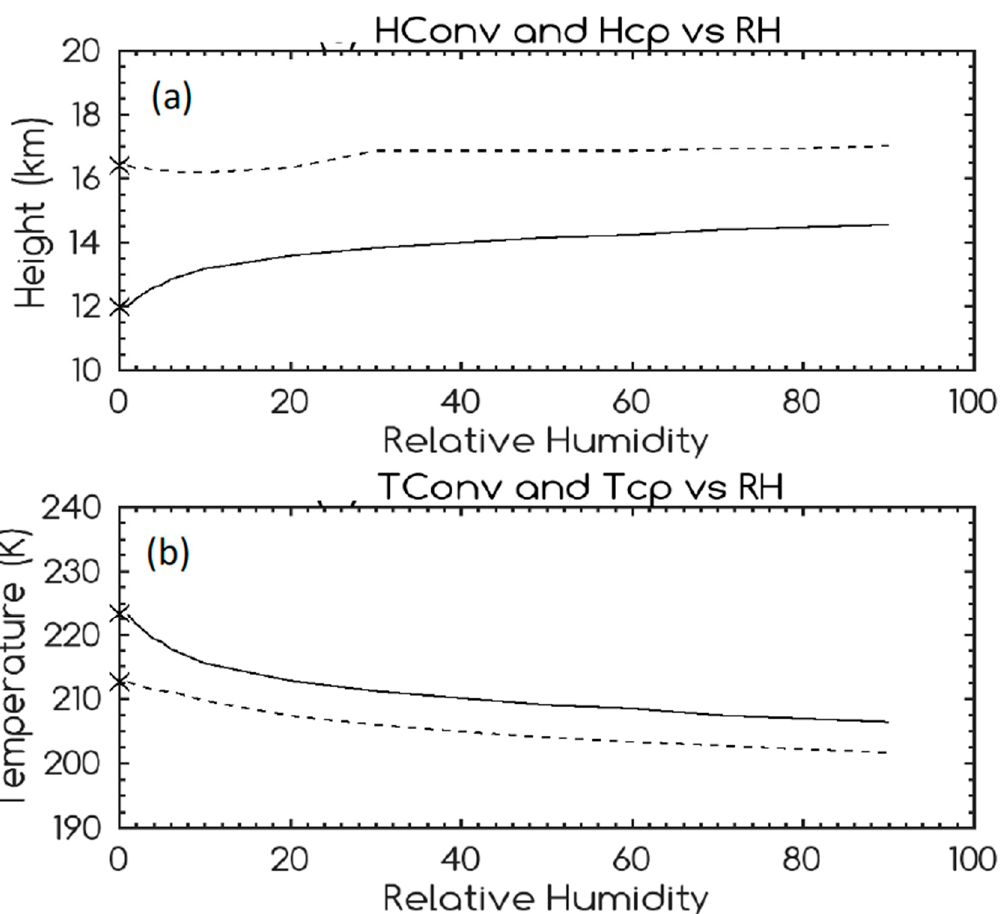
Figure 3. ( a ) Dependence of the convection-top height (solid) and the cold-point height (dashed) on the relative humidity. ( b ) Dependence of the convection-top temperature (solid) and the cold-point temperature (dashed) on the relative humidity.